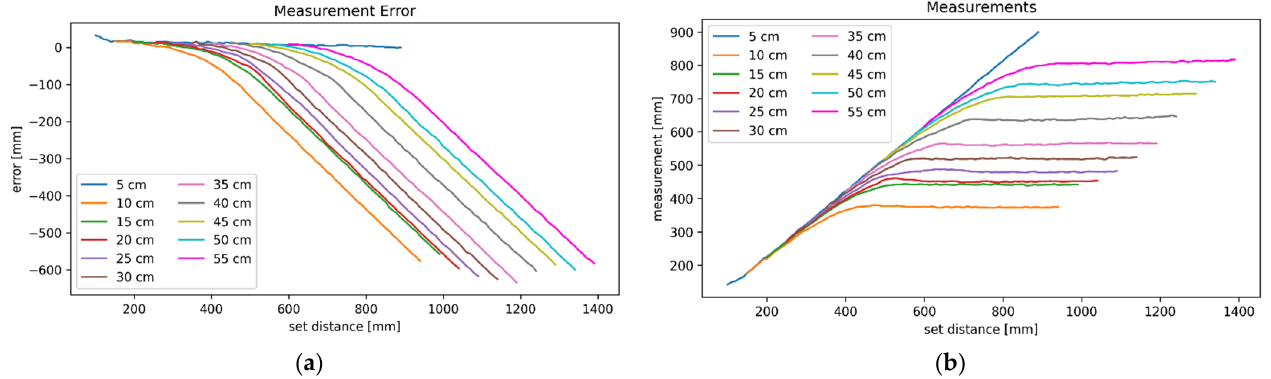
Figure 10. ( a ) Measurement error for the entire suite of measurements, from 5 cm to 55 cm distance between the ranging device and prism. ( b ) Compensated measurement data for the same datasets where x-axis is the measurement number. Which line corresponds to which configuration can be read from the legend. The explanation for the presented data is in the discussion section, where Figure 10 is